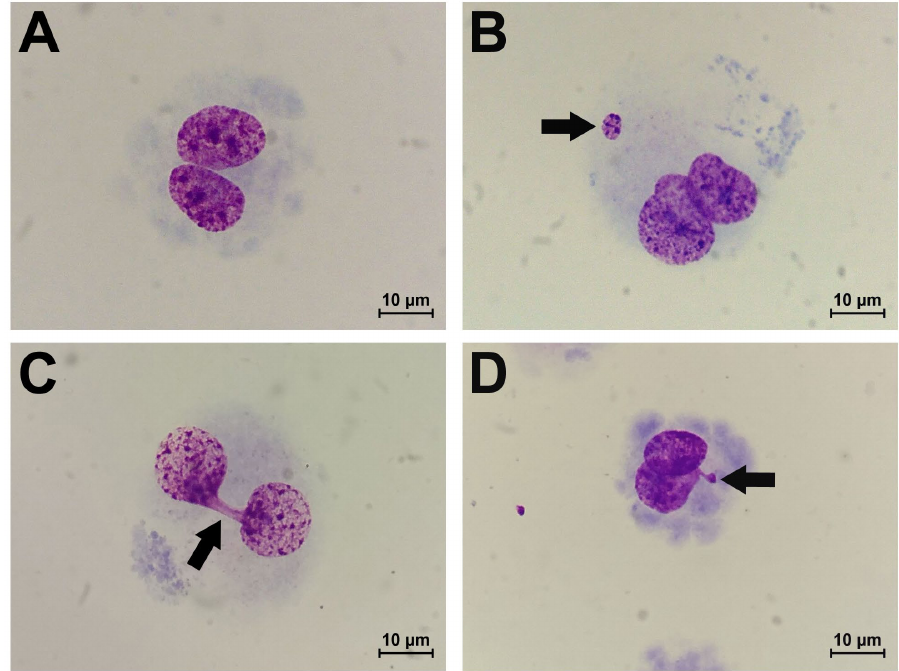
Figure 2. Morphology of undamaged BN endothelial cell ( A ), BN cell with MNi ( B ), BN cell with NPB ( C ), and BN cell with NBUD ( D ) at 1000× magnification (BN, binucleated; MNi, micronuclei; NPB, nucleoplasmic bridge; NBUD, nuclear bud).